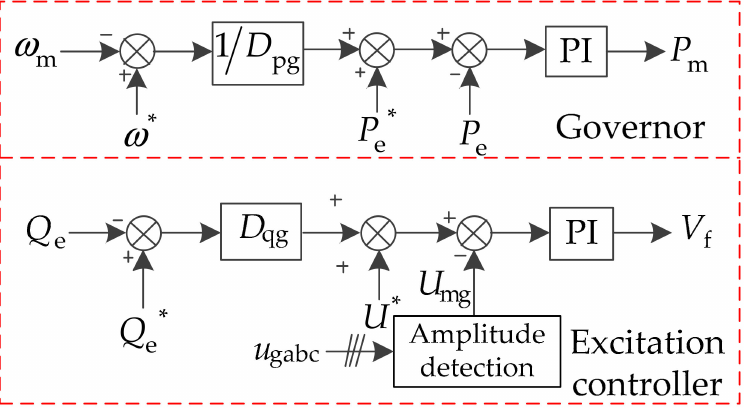
Figure 6. Control strategy of the synchronous